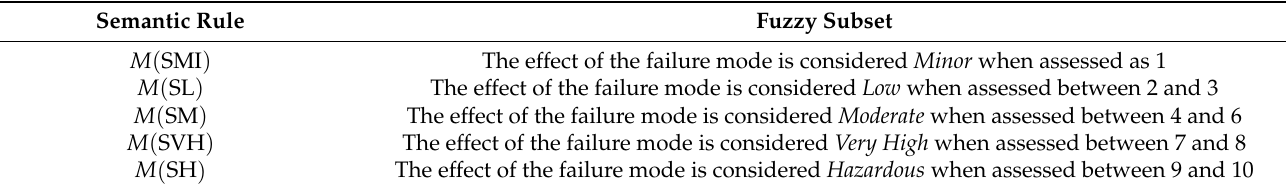
Table 1. Semantic rules for term-set Severity